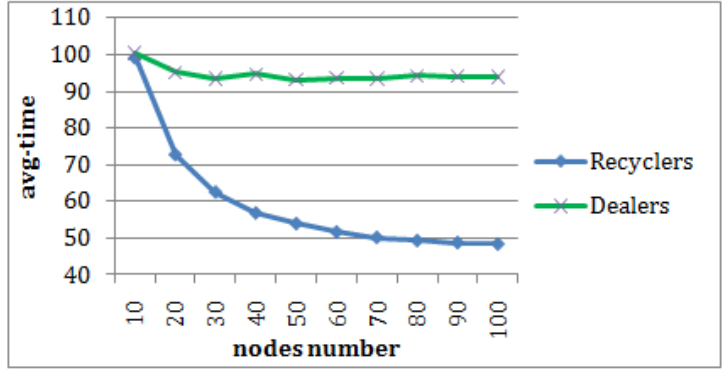
Figure 3. Influence of nodes number change in tiers on the average time of the whole process in the recovery